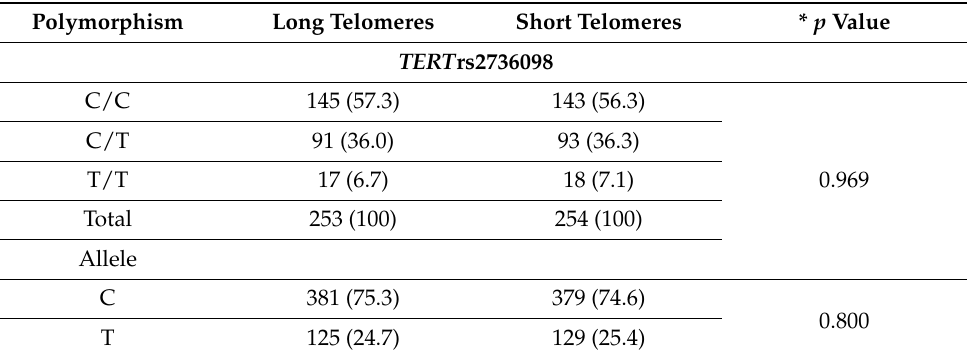
Table 5. Frequencies of genotypes and alleles of TERT rs2736098, rs401681, TRF1